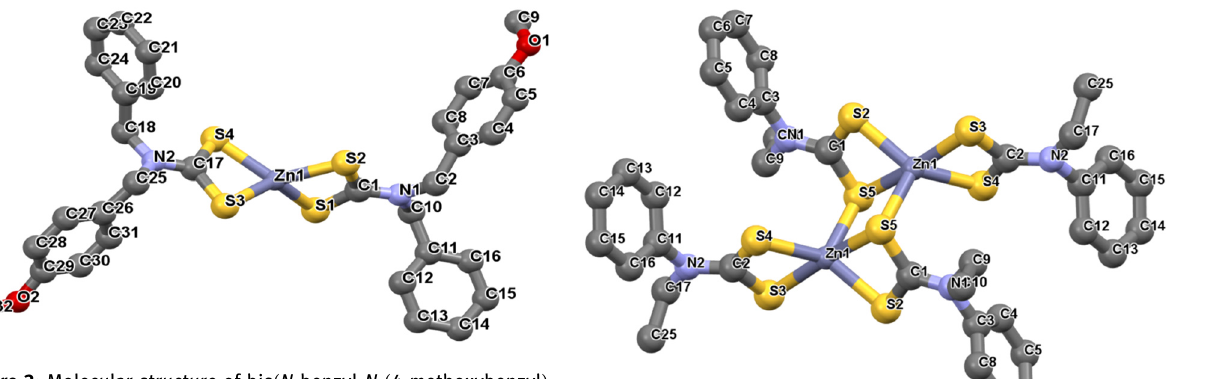
Figure 3: Molecular structure of bis ( N - benzyl - N -( 4 - methoxybenzyl ) dithiocarbamato - S,S ) zinc ( II ) . Redrawn from ref. [ 40 ] with permission from “ Taylor and Francis ” ( Copyright 2020 ) .